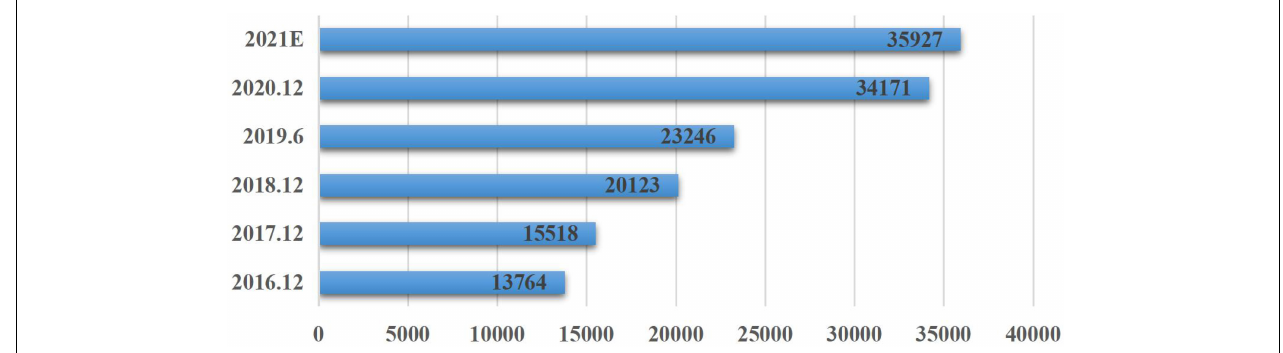
FIGURE 3 | Scale and forecast of online education users in China from 2016 to 2021 (user scale: 10,000). Source: https://bg.qianzhan.com/trends/detail/506/ 210730-5d593518.html.